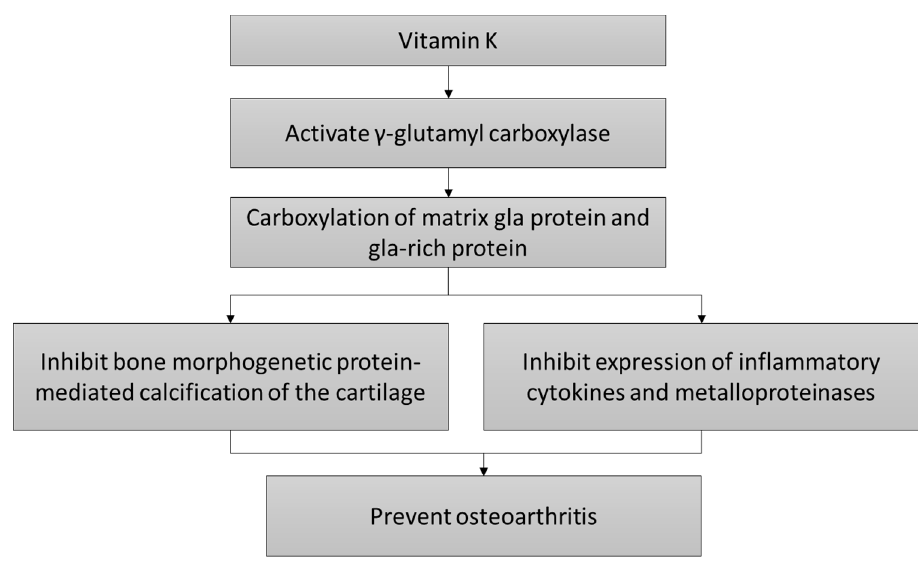
Figure 1. The cartilage protective mechanism of vitamin K.